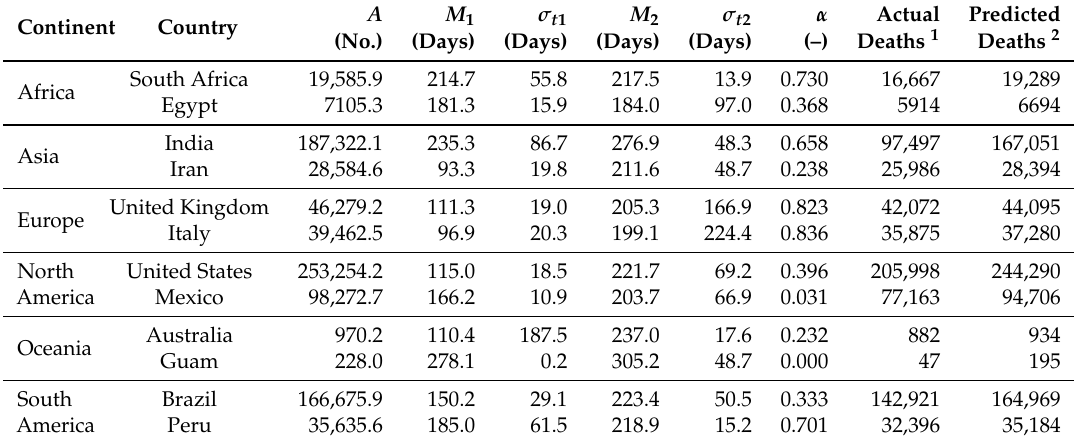
Table 3. Results for the two countries with largest number of actual deaths in each